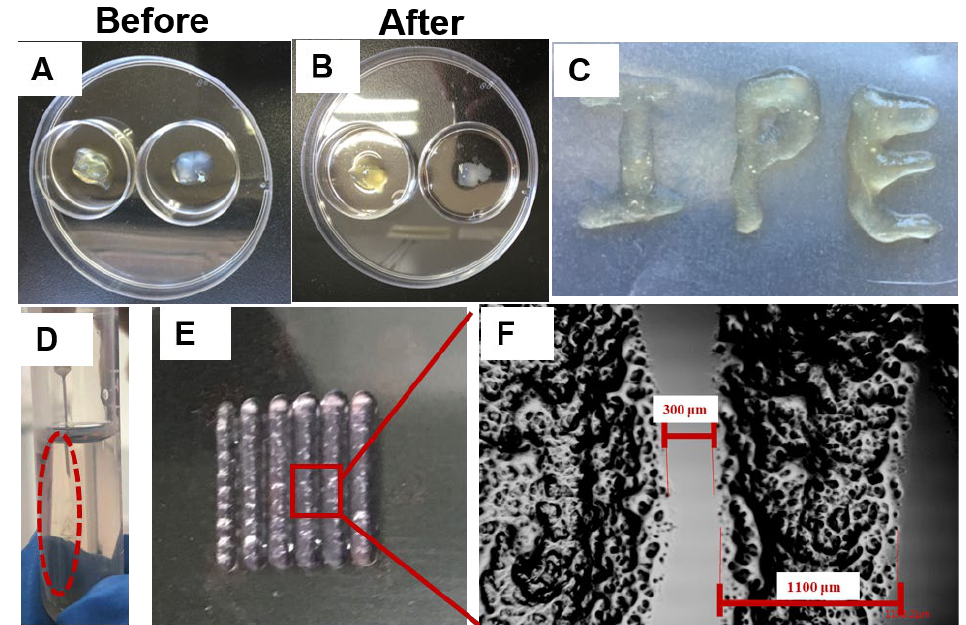
Figure 4. ( A , B ) stability characterization of the two kinds of hydrogel; ( C , D ) injectability character- ization of polyaniline doped conductive hydrogel; ( E , F ) printability characterization of polyaniline doped conductive